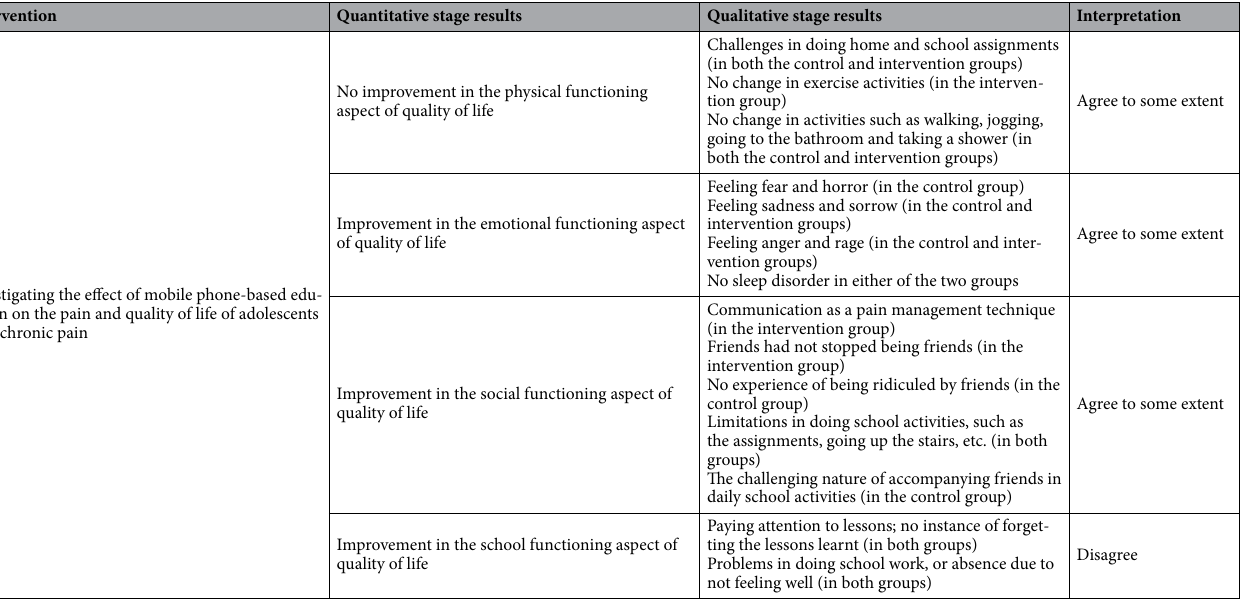
Table 6. Combining the qualitative and quantitative stage